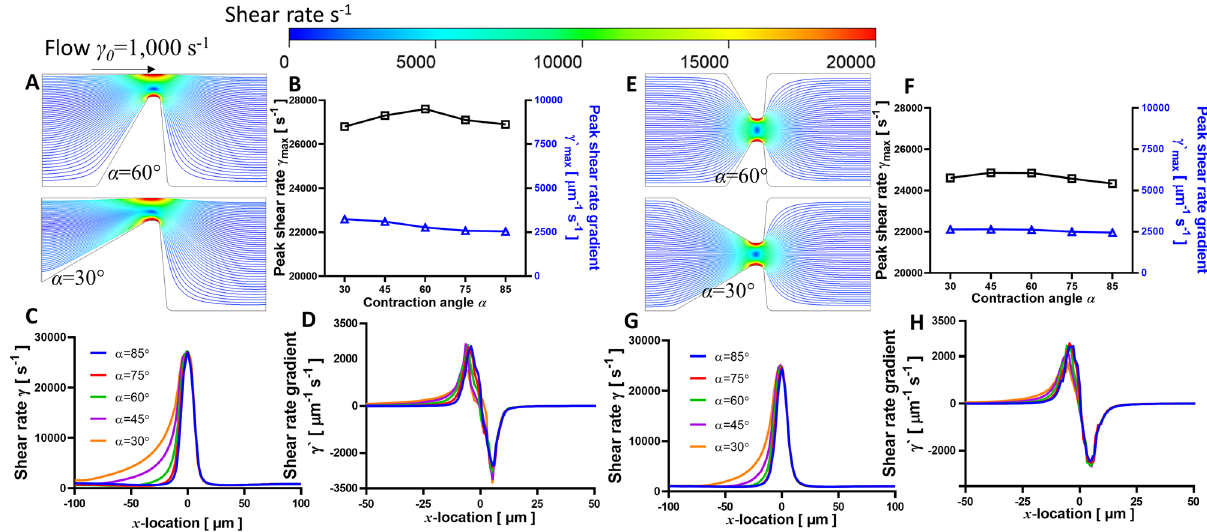
Figure 4. CFD simulated shear rates and shear rate gradients in eccentric ( A – D ) and concentric ( E – H ) stenoses geometry under various contraction angles. ( A and E ) The streamlines of blood flow in the eccentric stenosis and concentric stenosis microfluidic channel for α = 60° ( top ) and 30° ( bottom ) respectively. The representative streamline of a platelet trajectory was colored by shear rate values. ( B and F ) Peak shear rate γ max slightly changes correlated to the contraction angle for both eccentric and concentric stenoses geometries. Note that the eccentric stenosis upstream shear rate is higher than that of the concentric stenosis channel. The shear rate γ ( C and G ) and shear rate gradient γ ′ ( D and H ) distribution is plotted along a sample streamline 1 µm above stenosis apex spanning the shear acceleration ( x = −100 to 0 µm) and deceleration ( x = 0–100 µm) zones. Note that the shear rates in the post-stenosis zone remain unchanged with respect to α , while the upstream of the pre-stenosis area displays faster acceleration.